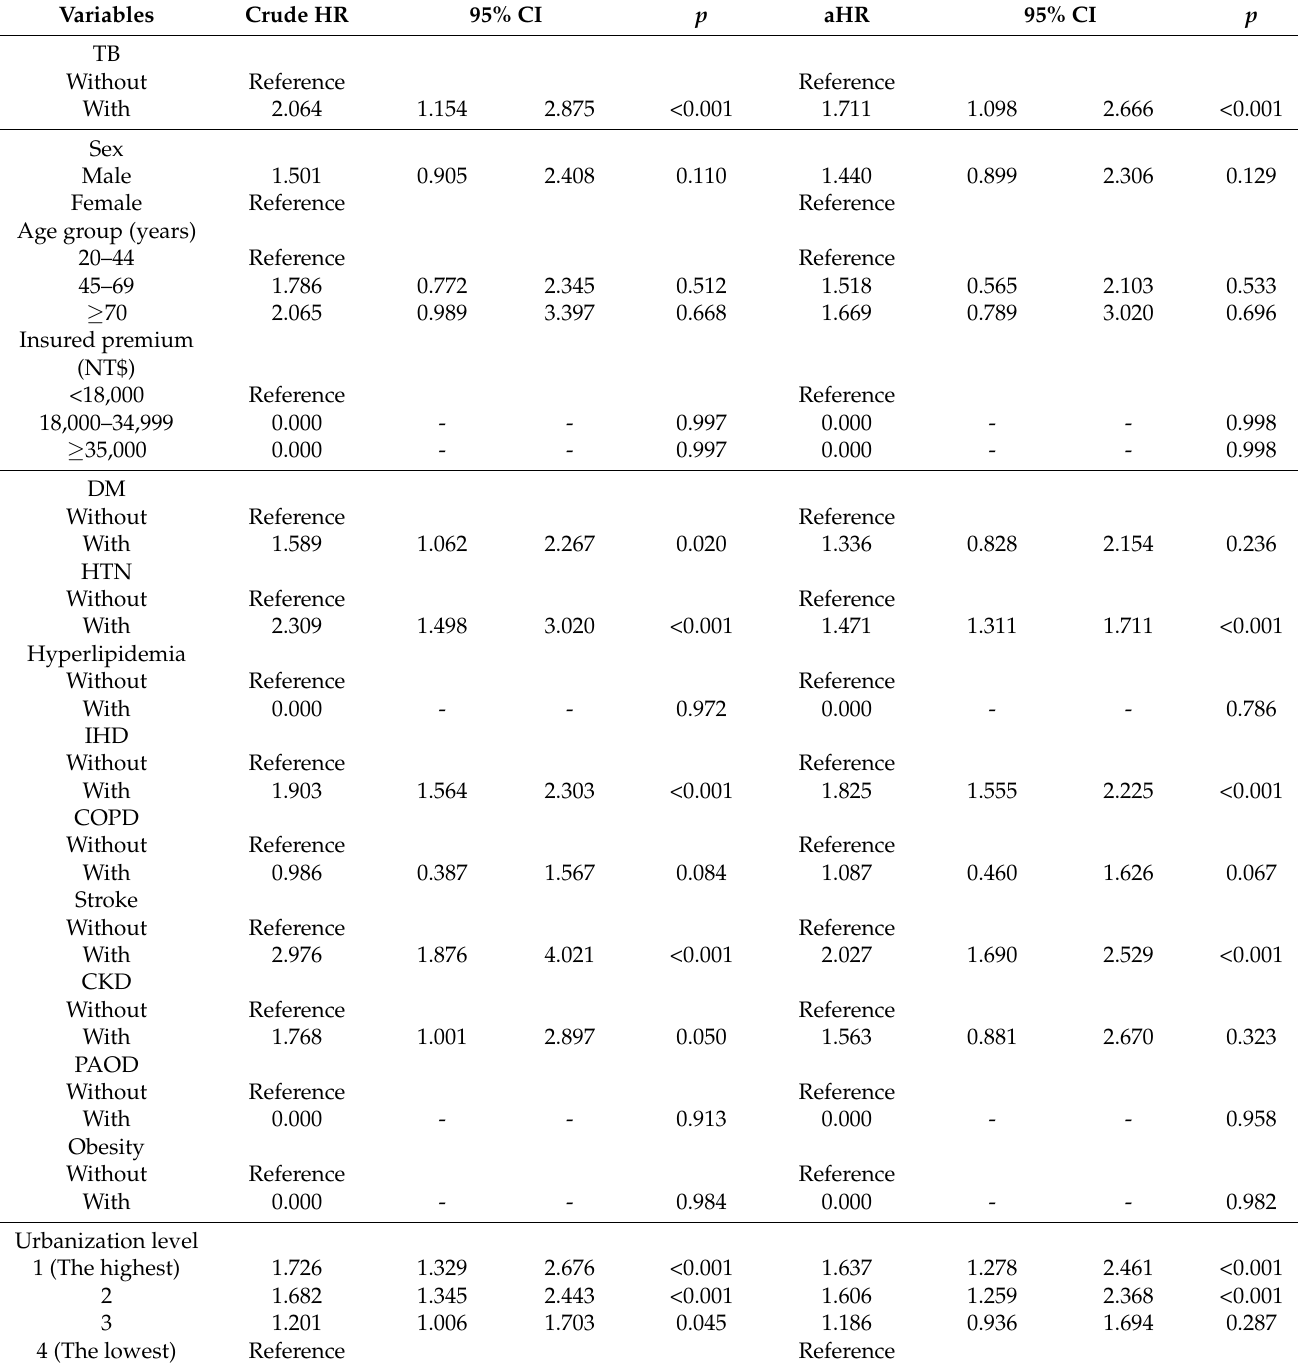
Table 2. Factors of aortic aneurysm and aortic dissection by using Cox